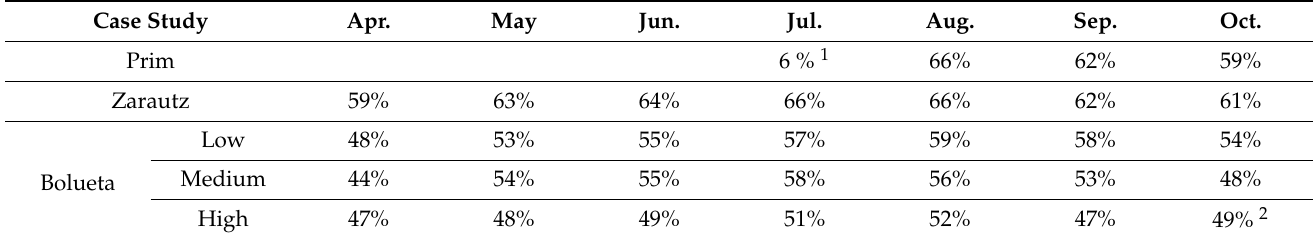
Table 7. Average monthly relative humidity (%), April–October 2020.